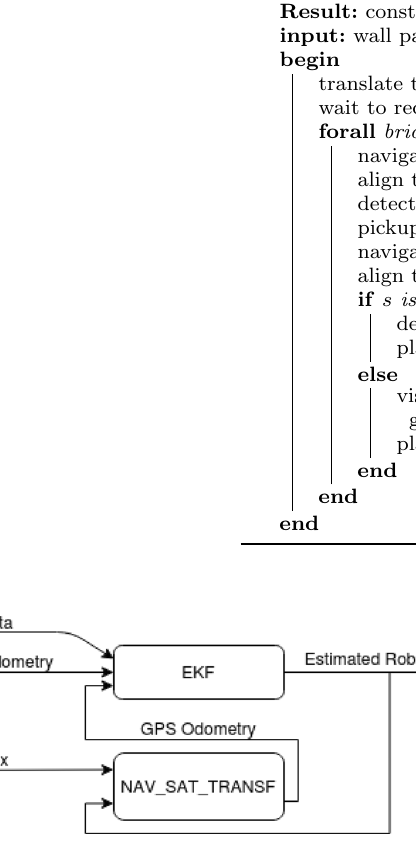
Algorithm 1: Challenge 2 routine